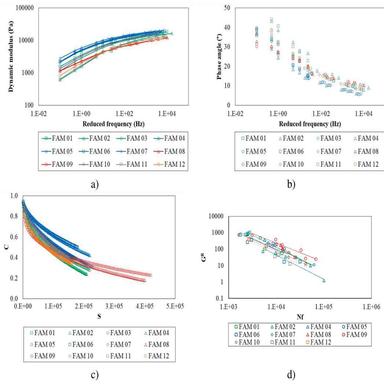
FAM characterization of a) dynamic modulus master curves in log–log scale at 20 ◦C, b) phase angle master curves at 20 ◦C, c) C vs. S fatigue damage characteristic curves at 20 ◦C, and d) experimental GR vs. Nf failure envelopes.